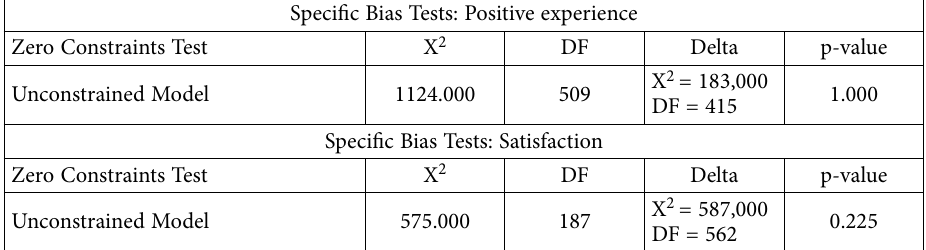
Table 5. Specific Bias Tests